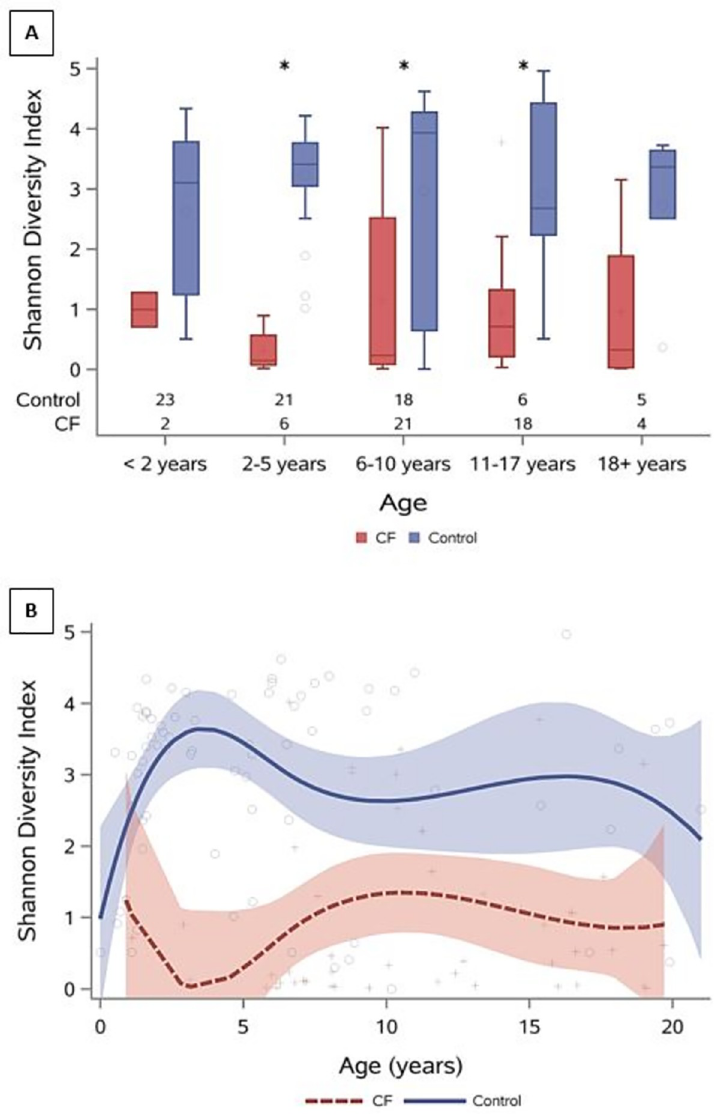
Fig 2. Diversity across age. (A) Bar plots comparing Shannon diversity index between CF and DCs at different ages, sample sizes are displayed along the x-axis and asterisks represent significant differences between CF and DC samples, and (B) Shannon diversity across the age spectrum. On average BALF samples from CF subjects have lower diversity compared to DCs, this is more pronounced starting at 1 year of age. pathogens ( i . e . Pseudomonas aeruginosa , Staphylococcus aureus , Haemophilus , Stenotrophomo-